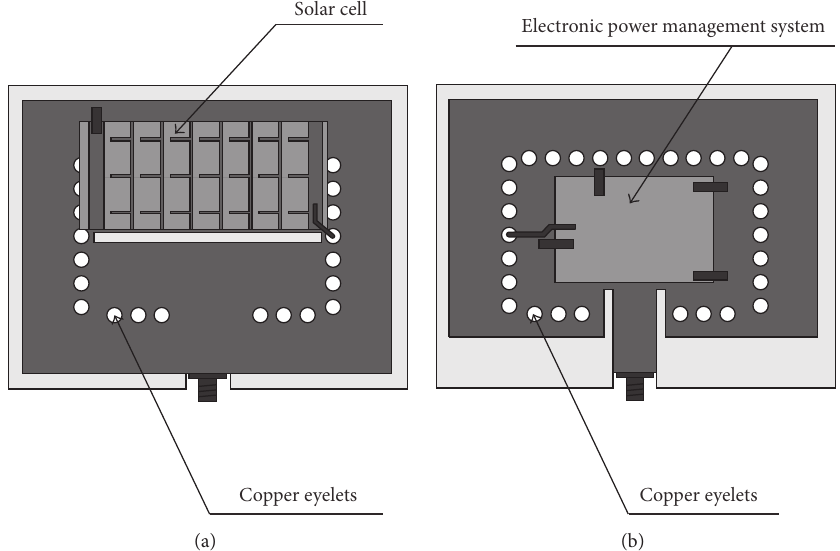
Figure 44: Geometry of the SIW cavity-backed slot wearable textile antenna with the integrated energy harvesting hardware [146]. Dark gray conductive textile and light gray dielectric textile substrate. The conductors employed to connect the solar cell and PMS are indicated in the figure. Top view (a) and bottom view (b).